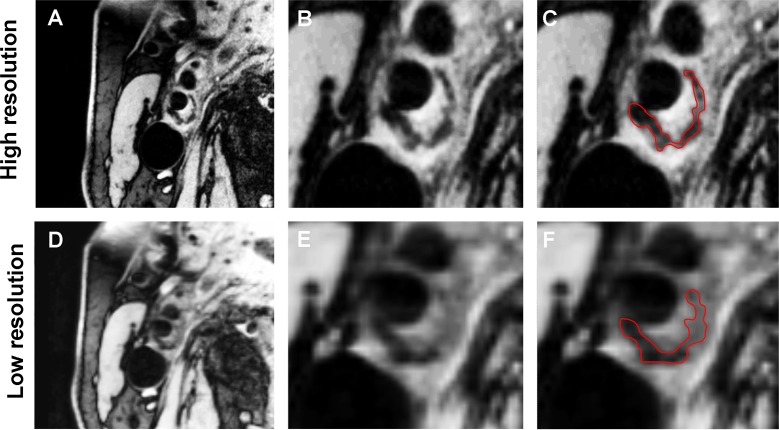
Representative sample of a HR and LR scan containing a calcified plaque area.Panel A and B show a HR image at a different magnification, with a manual delineated calcium contour obtained with the closed segmentation method (panel C). Panel D and E show a LR image at a different magnification, with a manual delineated calcium contour obtained with the closed segmentation method (panel F).